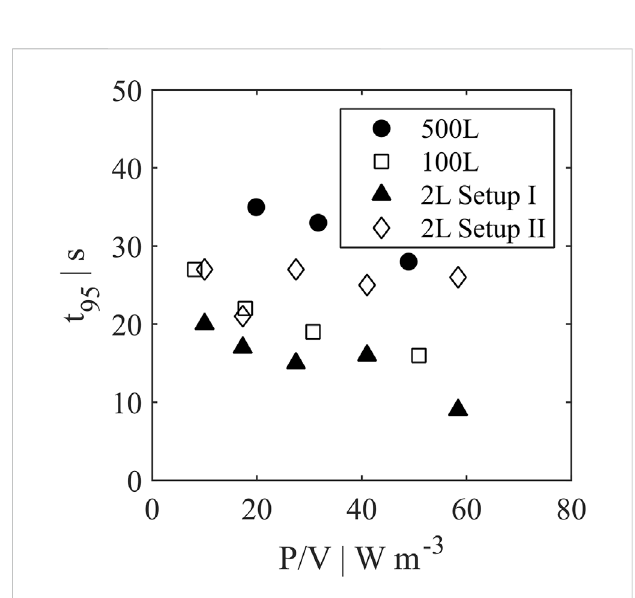
FIGURE 9 Comparison of residence time distribution of 2 L, 100 L and 500 L perfusion